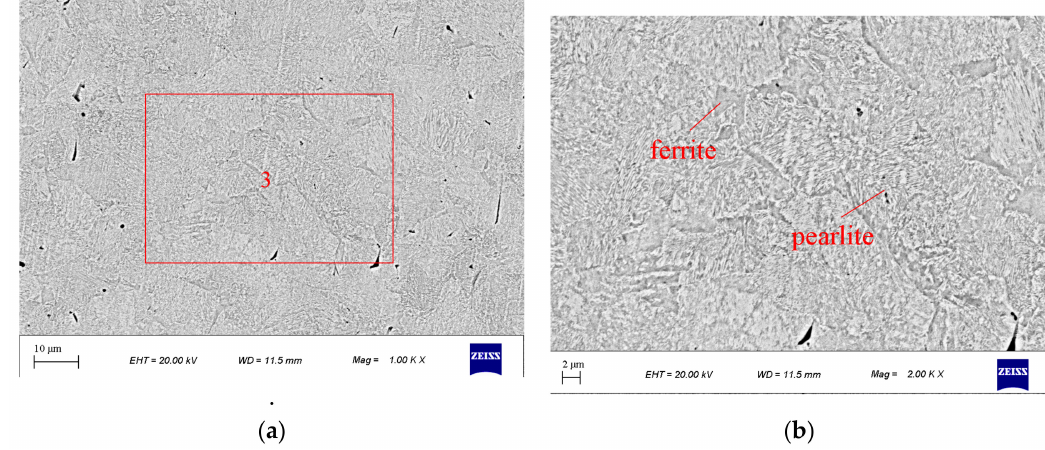
Figure 9. Morphology of matrix material; ( a ) 1000 × magnification and ( b ) area 3 at 2000 ×